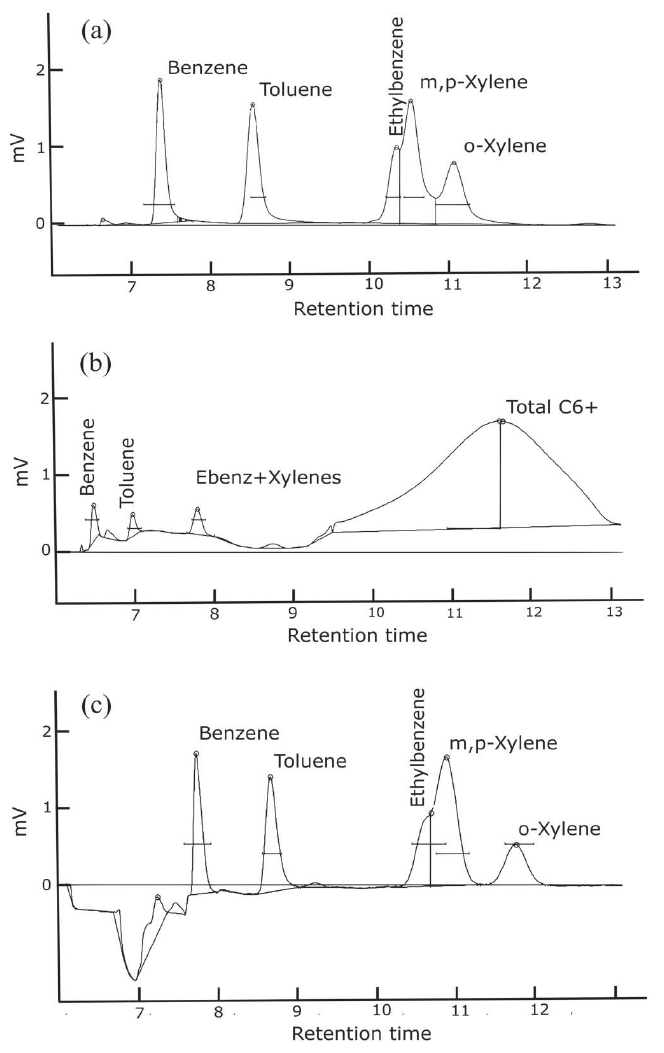
Figure 3. Sample chromatograms for three different column and flushing configurations with injection of a 1 ppb BTEX standard. Configurations: ( a ) Separation of heavier BTEX compounds is challenging with the selected columns. ( b ) Heavier hydrocarbons are detected; however, the baseline is not stable and separation of heavier BTEX compounds remains challenging. ( c ) There is better separation of the o-xylene; however, separation of ethylbenzene and m,p-xylenes still remains challenging. The baseline shifts when the 10-port solenoid valve rotates, and the precolumn configuration is no longer in series with the analytical column. This causes the column flow to increase and the baseline to shift as seen in ( c